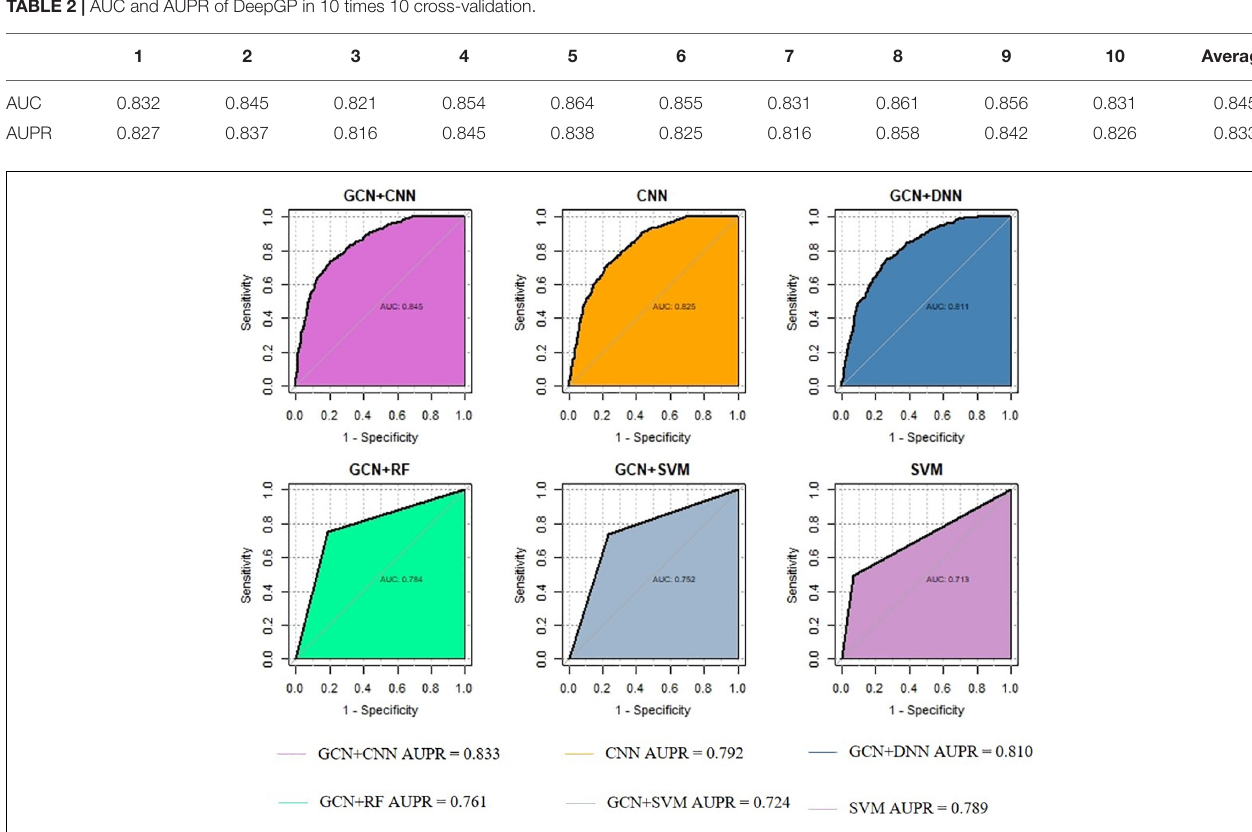
TABLE 2 | AUC and AUPR of DeepGP in 10 times 10 cross-validation.